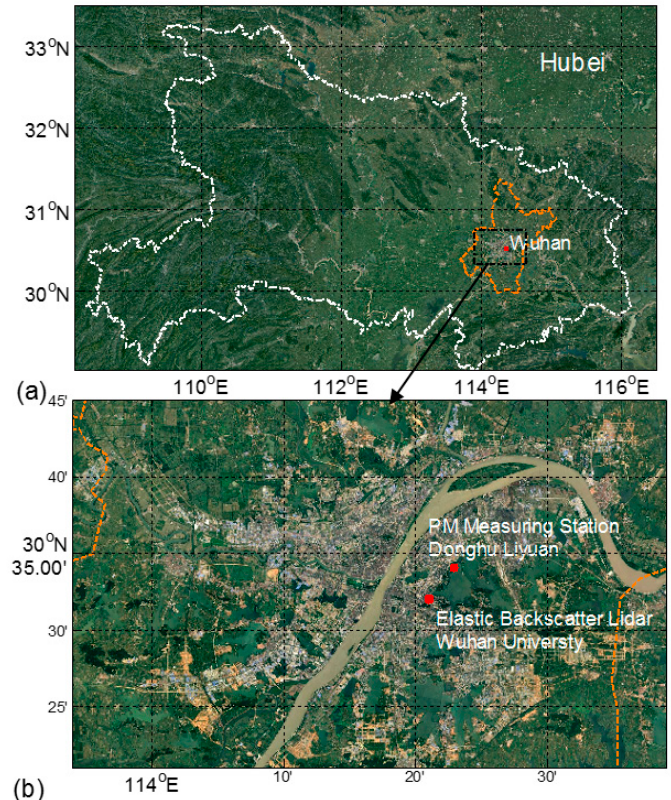
Figure 1. ( a ) Location of Wuhan in Hubei Province and ( b ) locations of this study in Wuhan University (ABLHs and meteorological conditions) and Donghu Liyuan (PM 2.5 and PM 10 ).